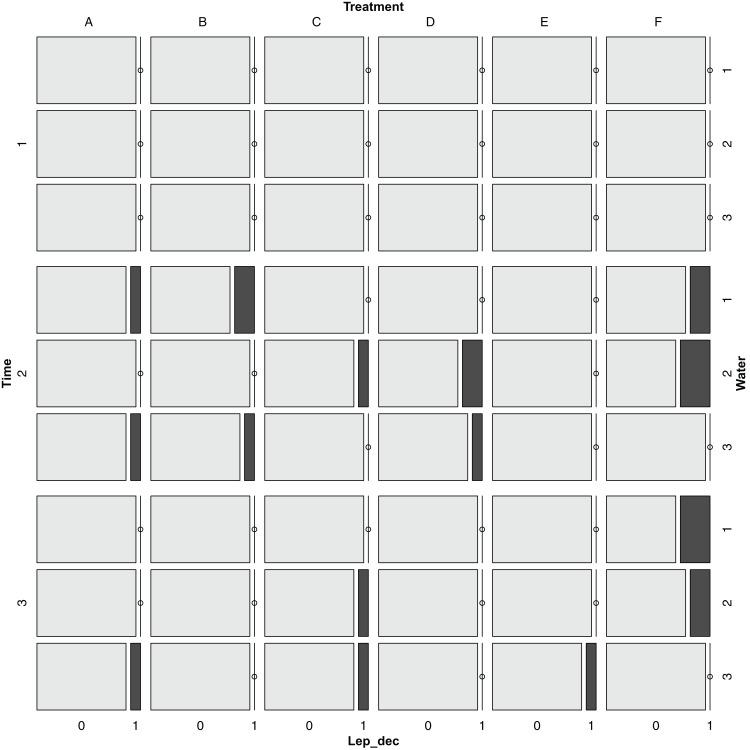
Mosaic plot for the presence of Leptinotarsa decemlineata for different times, treatments and watering regimes.Time dates (m/d) were T1: 4/14; T2: 5/3; T3: 6/1. Treatments are noted as (A) recommended Urtica dose; (B) half the recommended dose; (C) double the recommended dose; (D) Urtica recommended dose in combination with Equisetum; (E) Conventional foliar manure; (F) control. Watering regimes were 1: blocks 1 and 2; 2: blocks 3 and 4; 3: blocks 5 and 6.